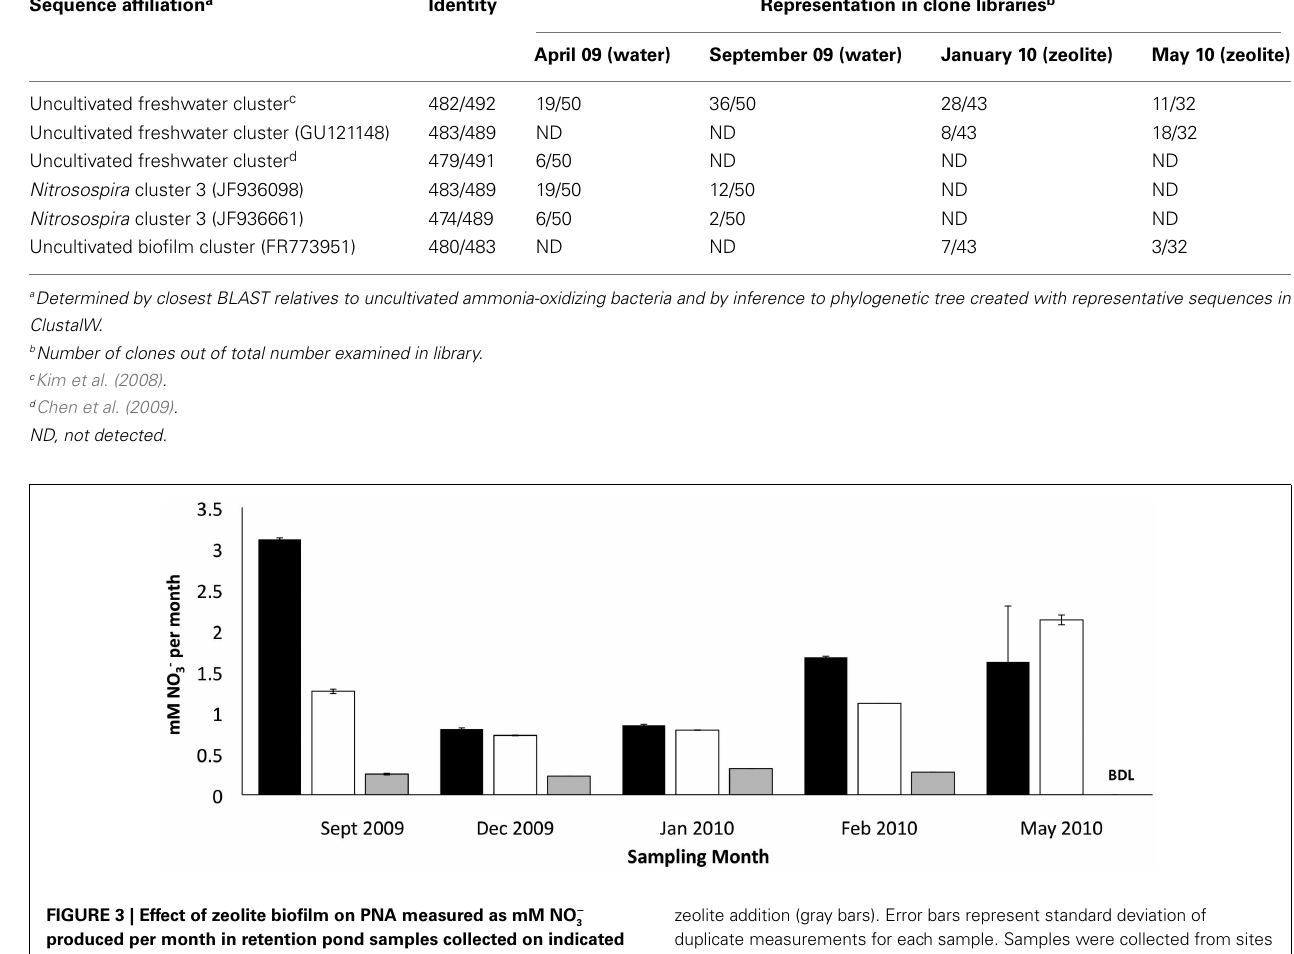
FIGURE 3 | Effect of zeolite biofilm on PNA measured as mM NO − produced per month in retention pond samples collected on indicated months. Incubation conditions were 12˚C with no zeolite addition (dark bars), 4˚C with developed zeolite biofilm (1g·5L − 1 ; white bars), and 4˚C with no